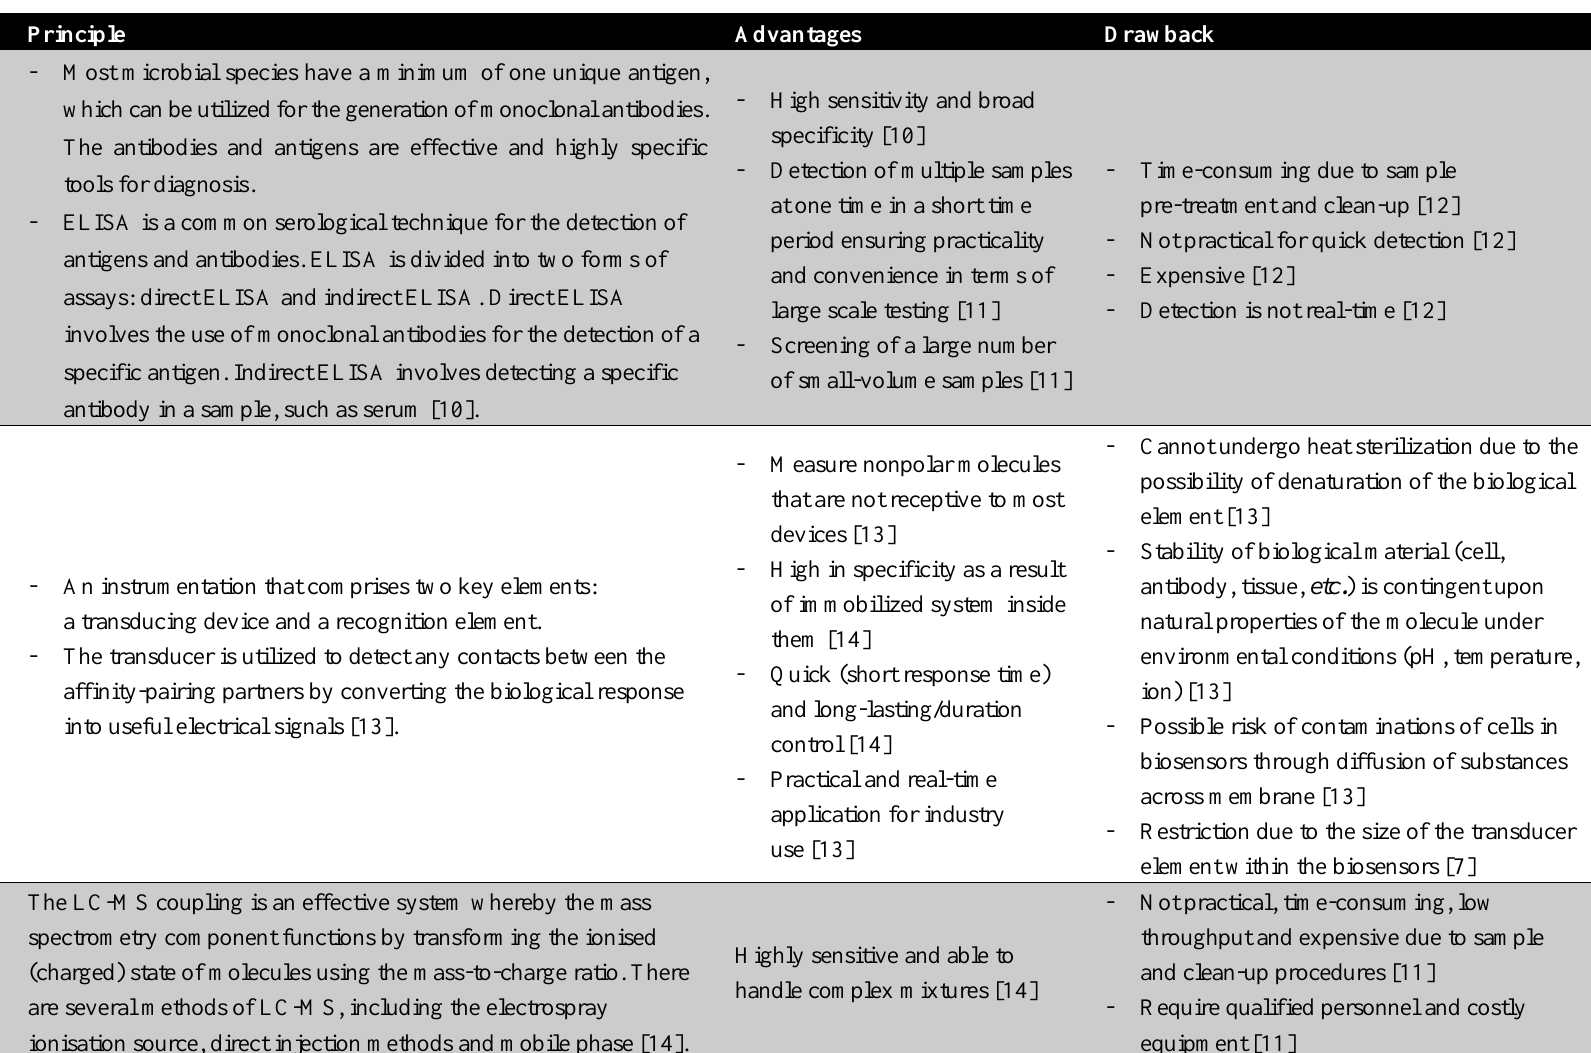
Table 1. Comparison of techniques for the detection of antibiotic residues in